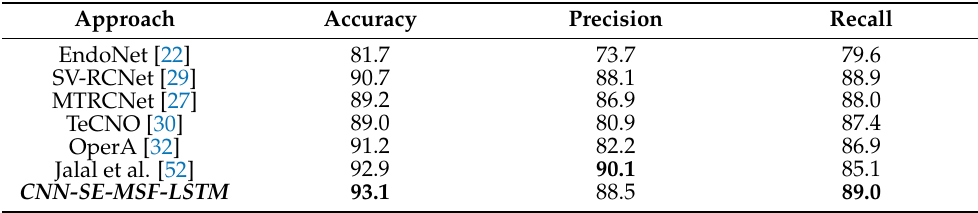
Table 5. Comparison of phase recognition results (%) of different approaches on the Cholec80 dataset (best performances are indicated in bold).